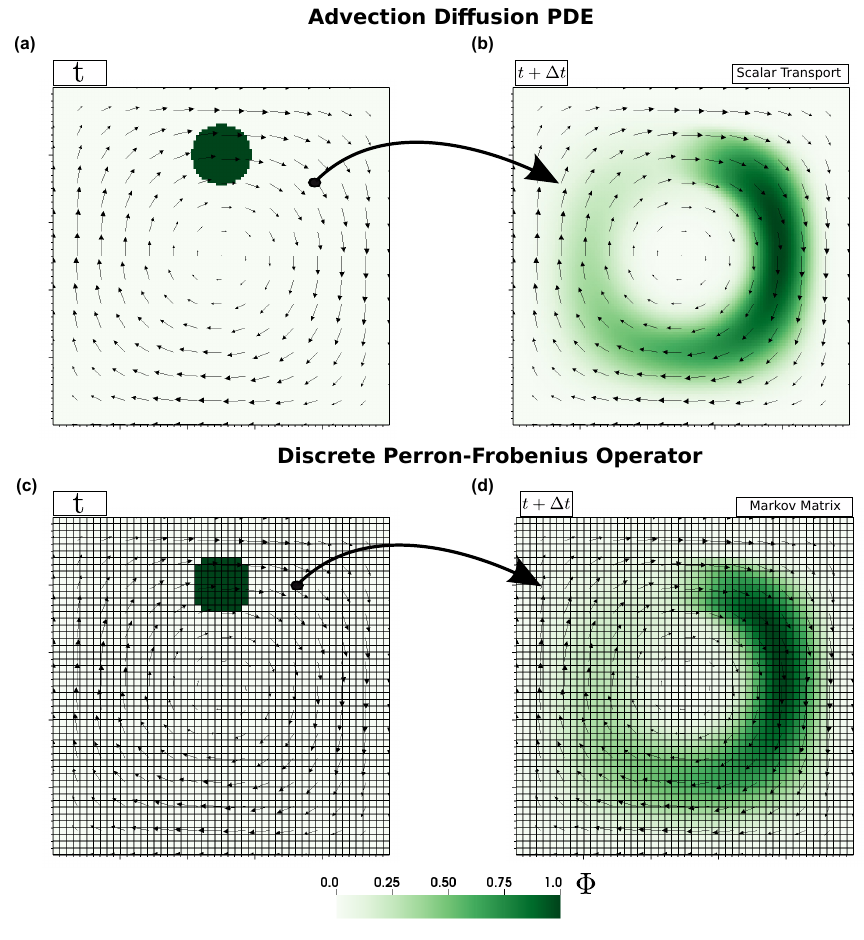
Figure 1. For the given velocity field ( a , b ) Shows the contaminant transport using the scalar transport Equation (1) ( c , d ) Shows the discrete PF-operator based scalar